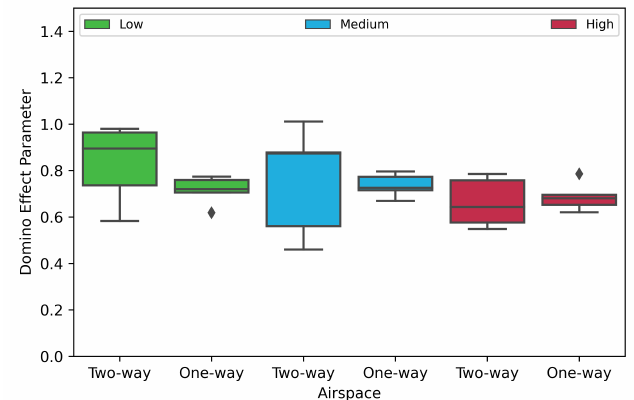
Figure 9. Domino Effect Parameter (DEP) for the two-way and one-way urban airspace concept for low, medium and high traffic demands. Note that the one-way concept have slightly lower DEP values as compared to the two-way